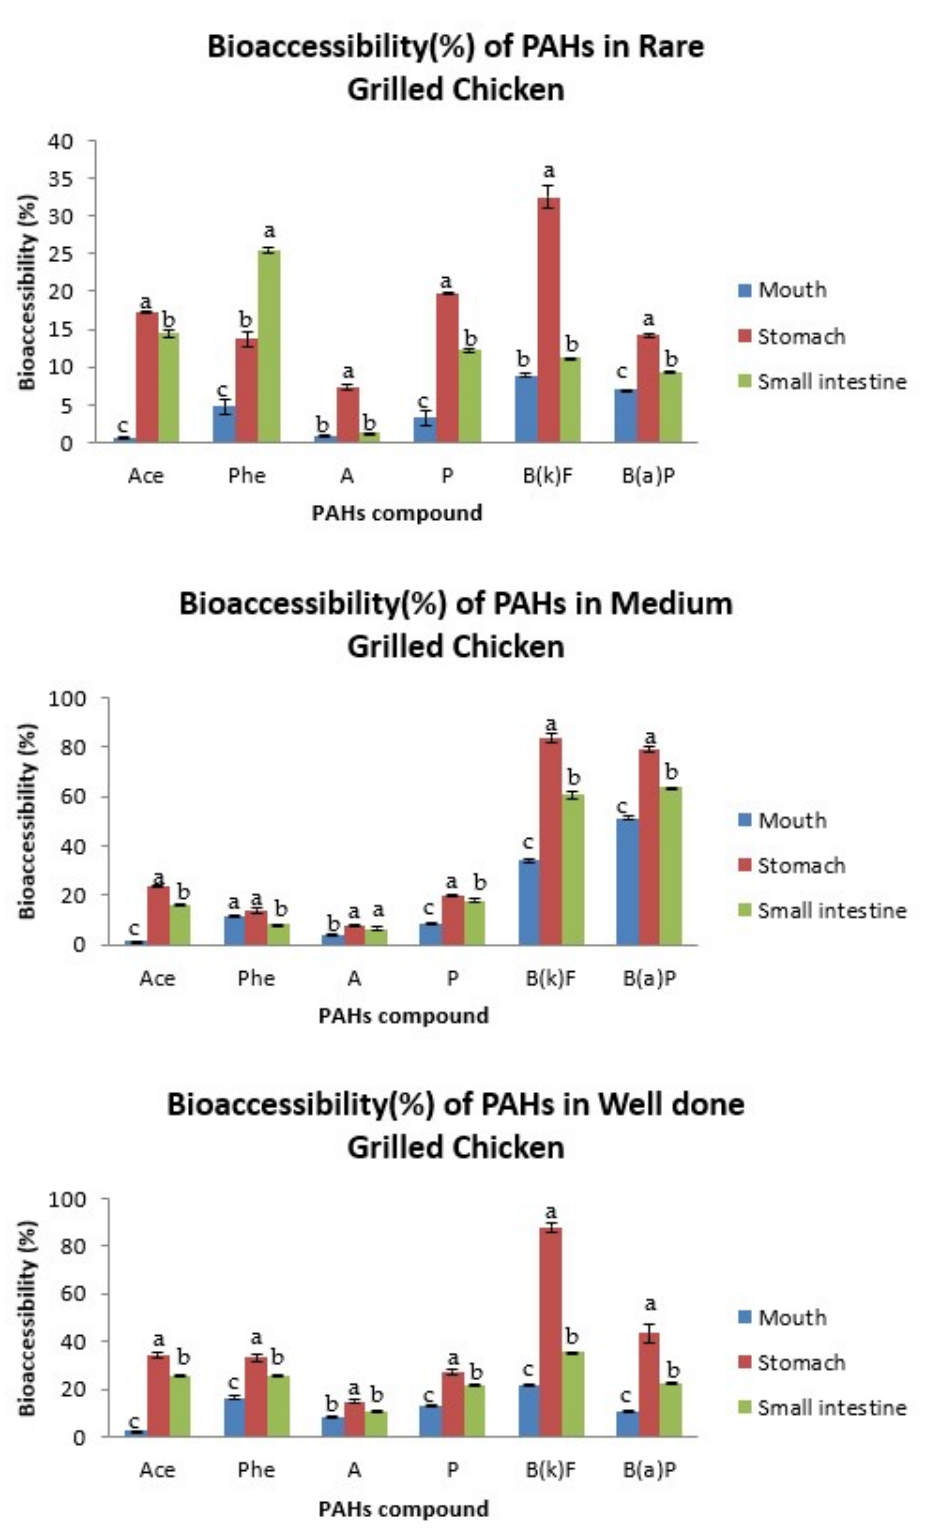
Figure 3. Bioaccessibility (%) of PAHs in rare, medium and well-done grilled chicken samples in different parts of digestive system. Different letter indicates significant difference in PAH’s bioavailability among the different parts of the digestive system. Ace, acenaphthene; Phe, phenanthrene; A, anthracene; P, pyrene; B(k)F, benzo(k)fluoranthene; B(a)P, benzo(a)pyrene.